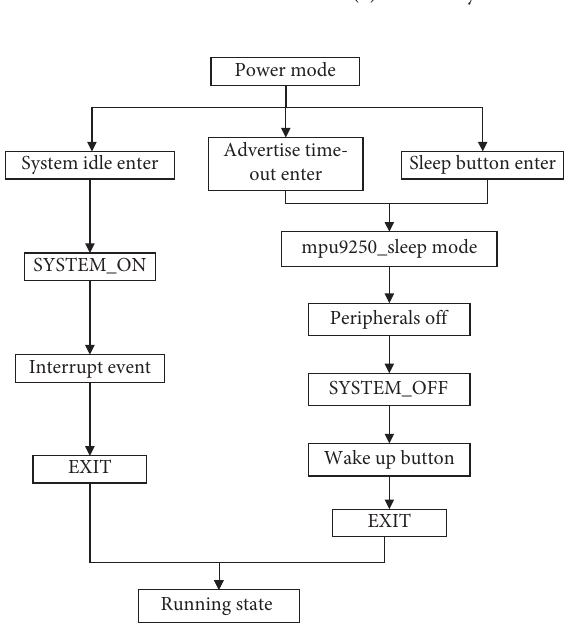
Figure 2: Low power mode